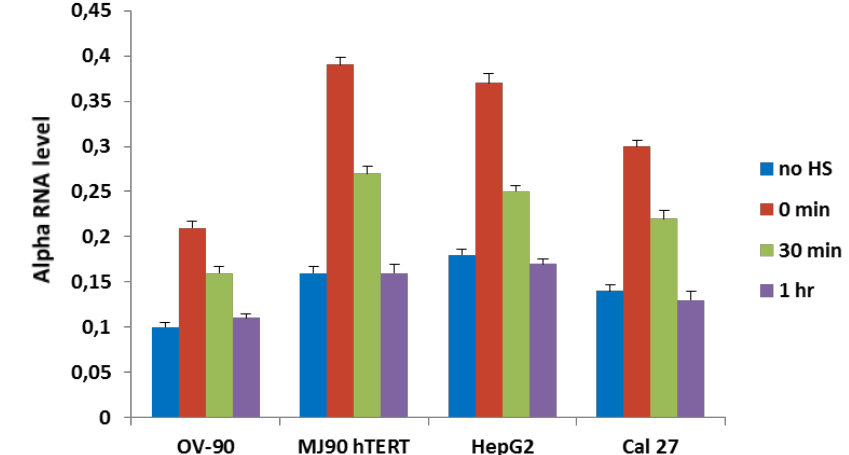
Figure 1. The dynamics of transcription of alpha satellite DNA in cell lines OV-90, MJ90 hTERT, HepG2 and Cal 27 under standard conditions (no HS), immediately after 2 h of heat stress at 42 ◦ C (0 min), at 30 min and 1 h of recovery at 37 ◦ C, respectively. Two experiments were performed on each cell line. No represents normalized average No value. Columns show average of two di ff erent RT-qPCR experiments performed in triplicate and error bars represent standard deviations.